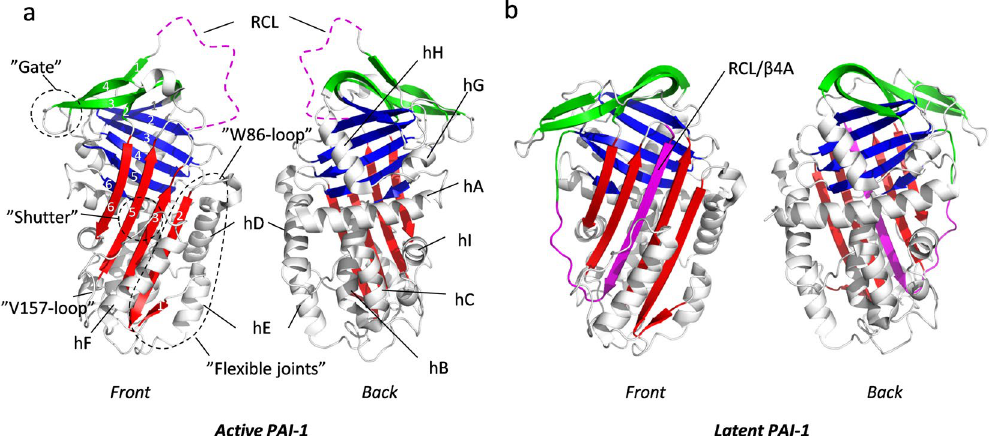
Figure 1. Structure of active and latent PAI-1. ( a ) crystal structure of the W175F mutant of PAI-1 in the active conformation (PDB 3Q02). β -sheet A, B and C are shown in red, blue and green, respectively. RCL residues missing in the PDB 3Q02 are sketched as a purple broken line. Other secondary structures and named regions are indicated in the figure. ( b ) Structure of wild-type PAI-1 in the latent conformation (PDB 1DVN). Color coding is the same as in ( a ). In this conformation the RCL (purple) is inserted as an extra β -strand in the middle of β -sheet